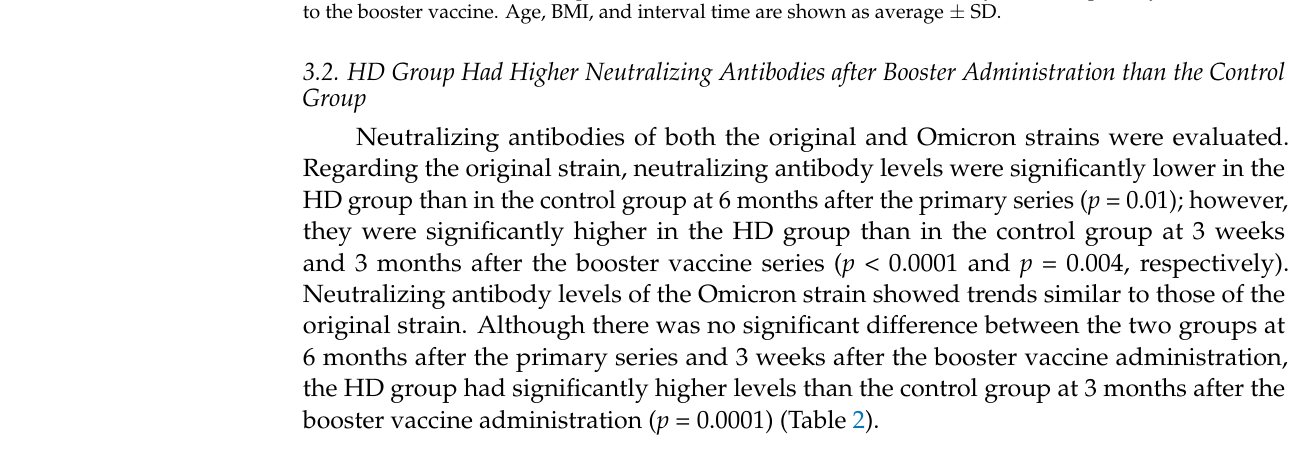
Table 2. Neutralizing